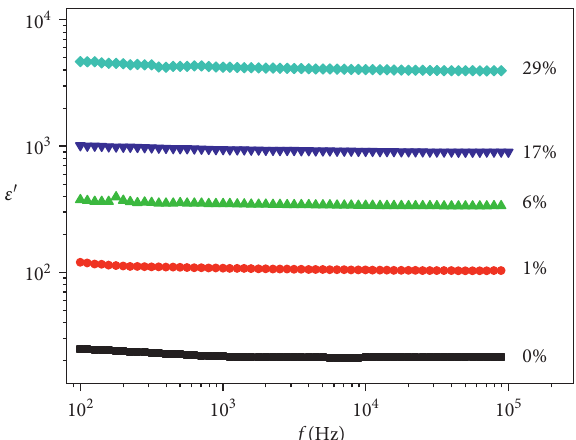
Figure 3: Dielectric constant vs. frequency for systems based on the epoxy matrix containing CBN.